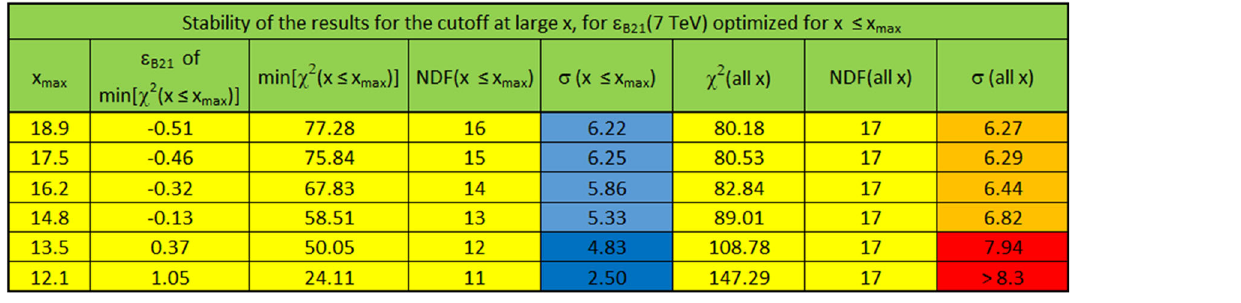
Table 10 The trade-off effect of using model dependent results: If we utilize the ReBB model instead of H ( x ) scaling, it decreases the sig- √ s = 1 . 96 TeV, from 6.26 nificance of the pp prediction vs p ¯ p data at down to 2.19 σ . However, as a trade-off, the same model allows for an √ s = 2 . 76 TeV, which was not possible extrapolation of the p ¯ p data to with the help of the H ( x ) scaling. This p ¯ p differential cross-section vs √ pp data at s = 2 . 76 TeV results in a 7.12 σ effect. The combined significance of the ReBB model on both the 1.96 TeV D0 and 2.76 TeV TOTEM data is found to be 7.08 σ . Thus the lower limit of